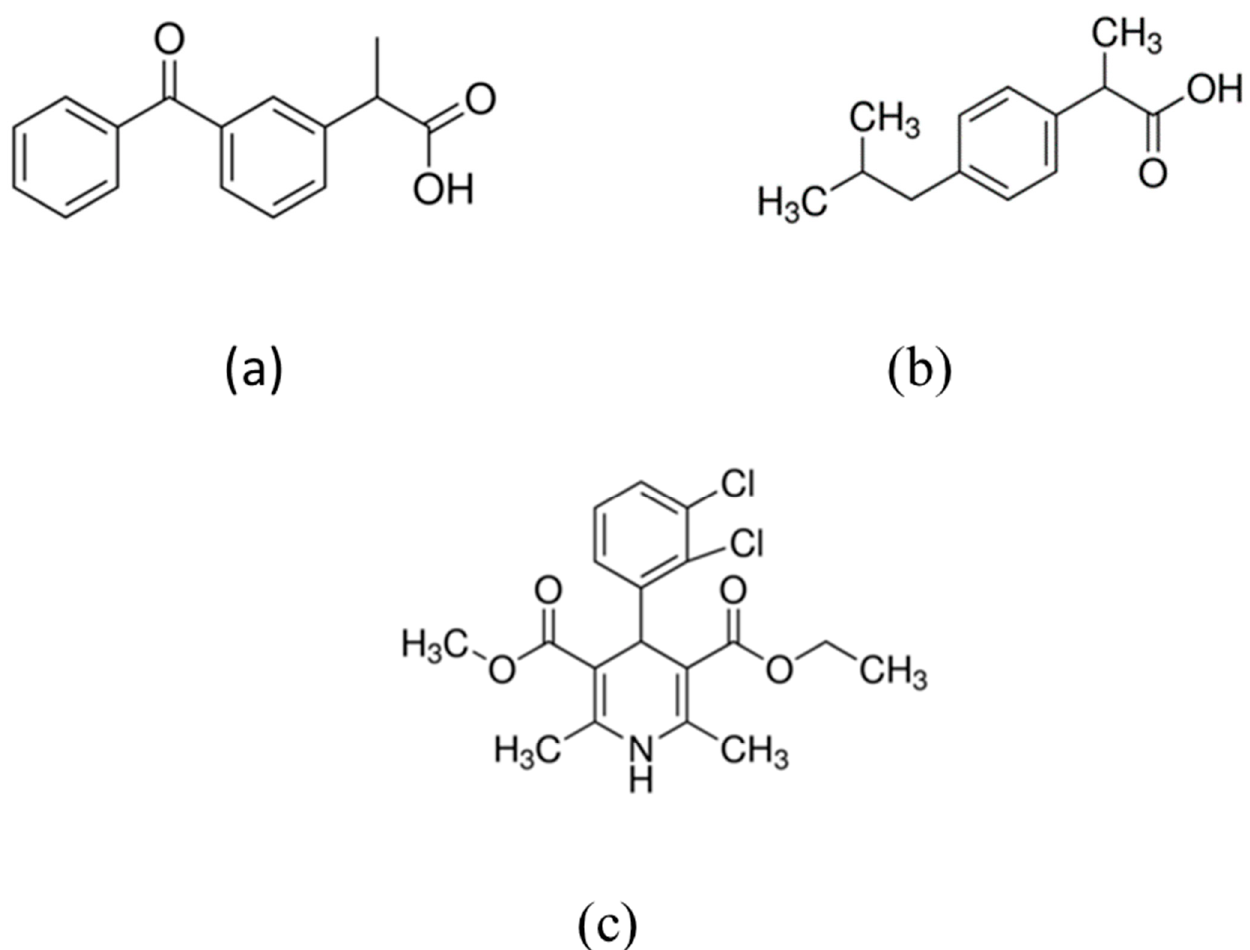
Figure 1. Chemical structures of ( a ) ketoprofen ( b ) ibuprofen and ( c ) felodipine.